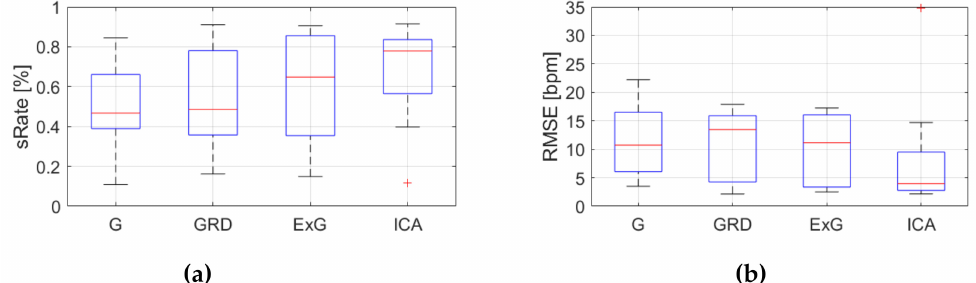
Figure 6. Comparison of signal extraction methods, algorithm No.1 (PSD): ( a ) box plots for sRate ; ( b ) box plots for RMSE . Blue lines—IQR range, red line—median value.